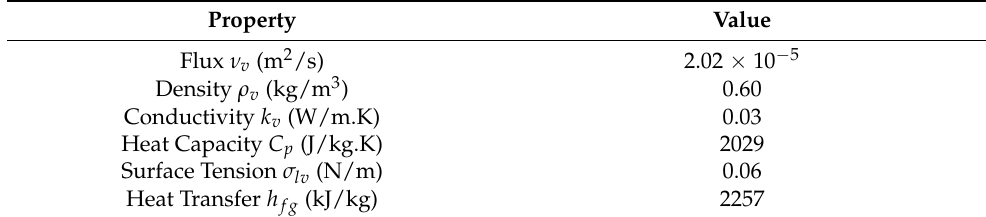
Table 4. Vapor phase properties and surface tension at saturation temperature and atmospheric